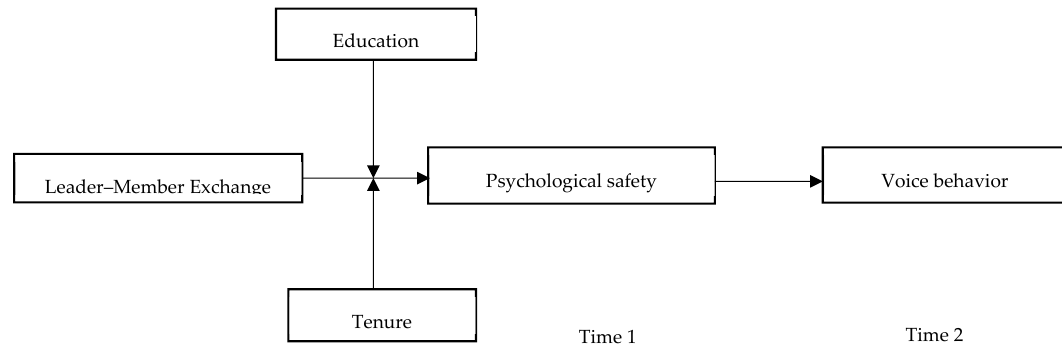
Figure 1. Hypothesized research model.